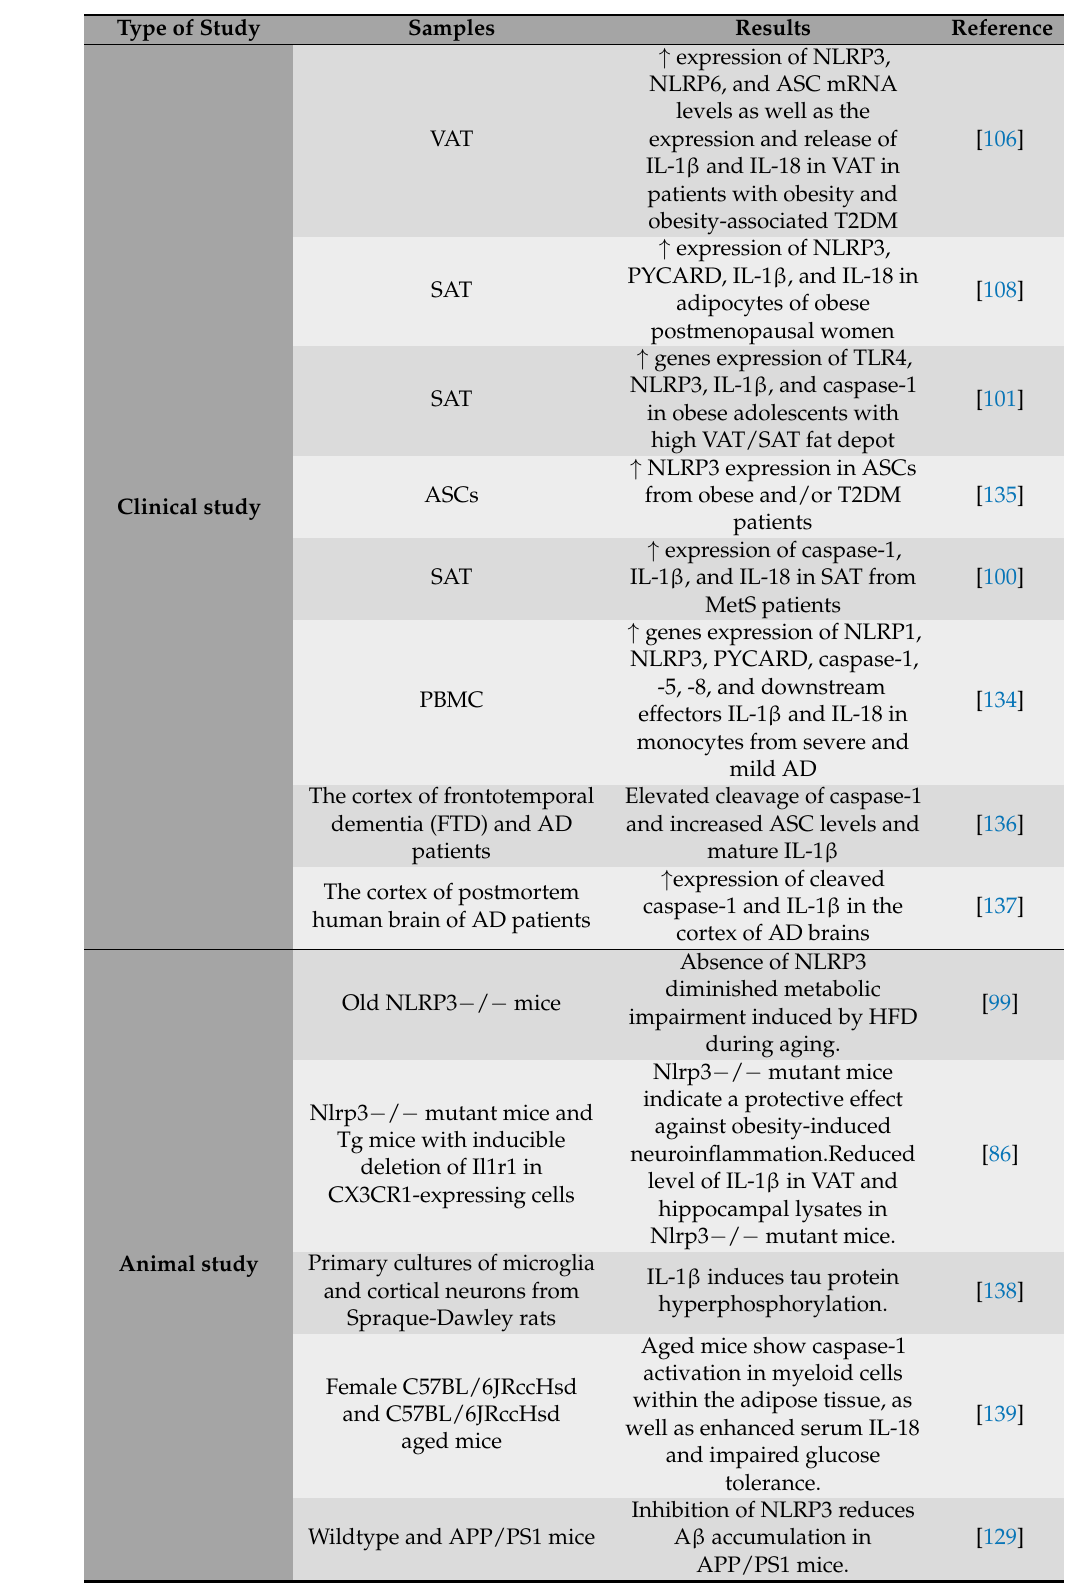
Table 1. Findings from clinical studies and animal models concerning NLRP3 activity in metabolic diseases and AD. VAT, visceral adipose tissue; SAT, subcutaneous adipose tissue; ASC, adipose- derived stem cells; PBMC, peripheral blood mononuclear cell; STZ,